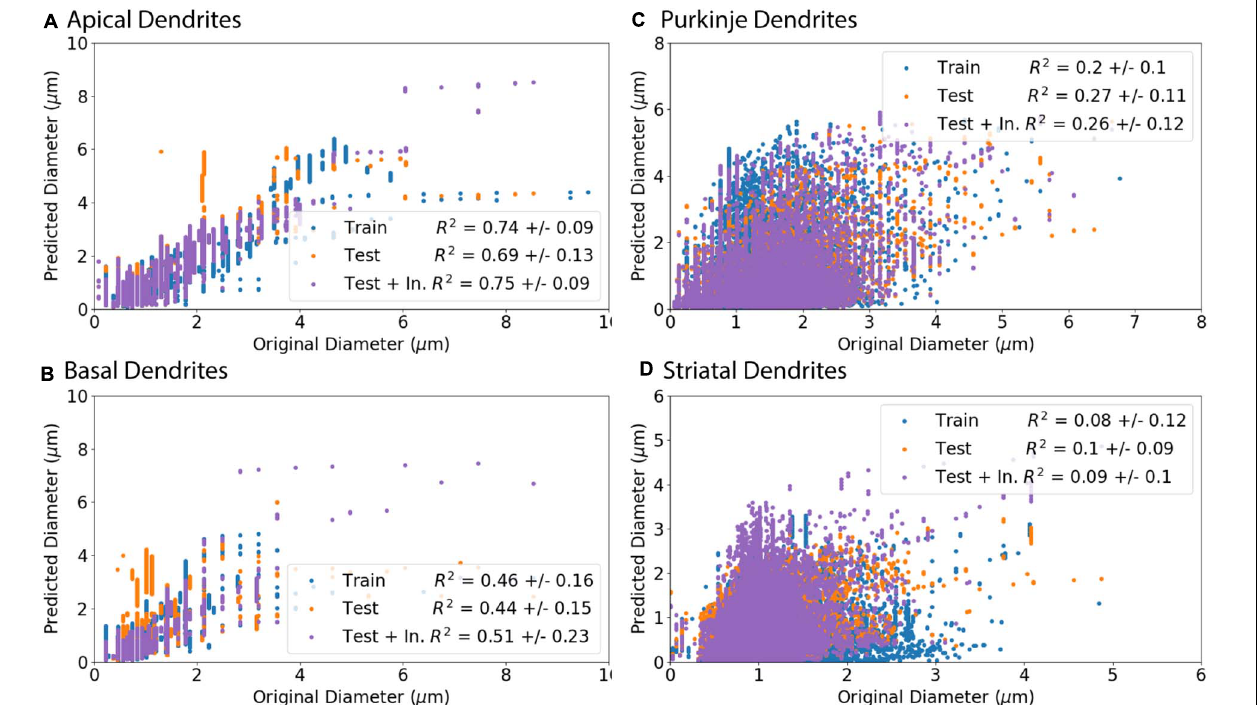
Initial nodes Branch children